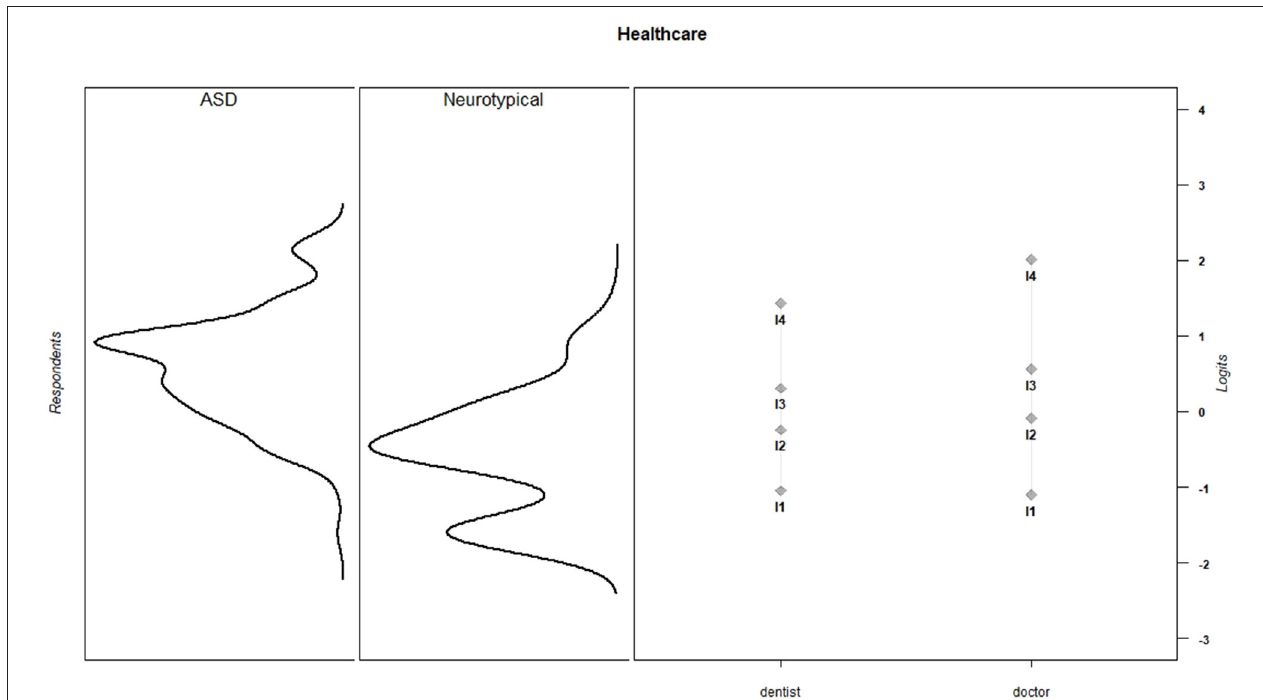
FIGURE 6 | Healthcare item parameters and person parameters by